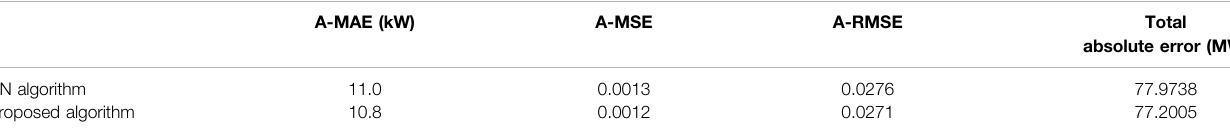
TABLE 3 | Error comparison between NN and proposed forecasting algorithm based on 200